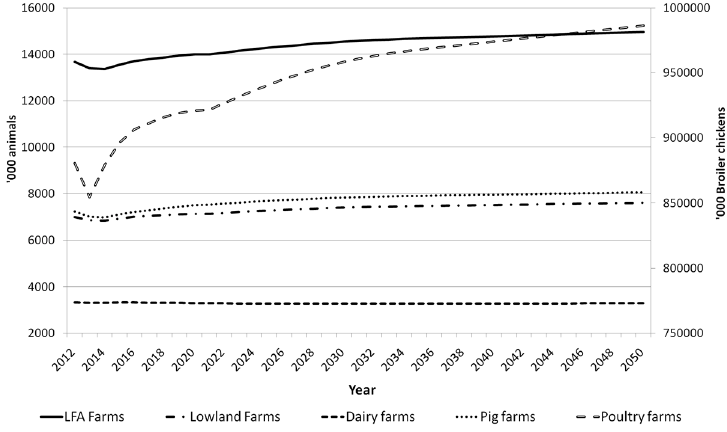
Figure 5. Total animal projections in farms.